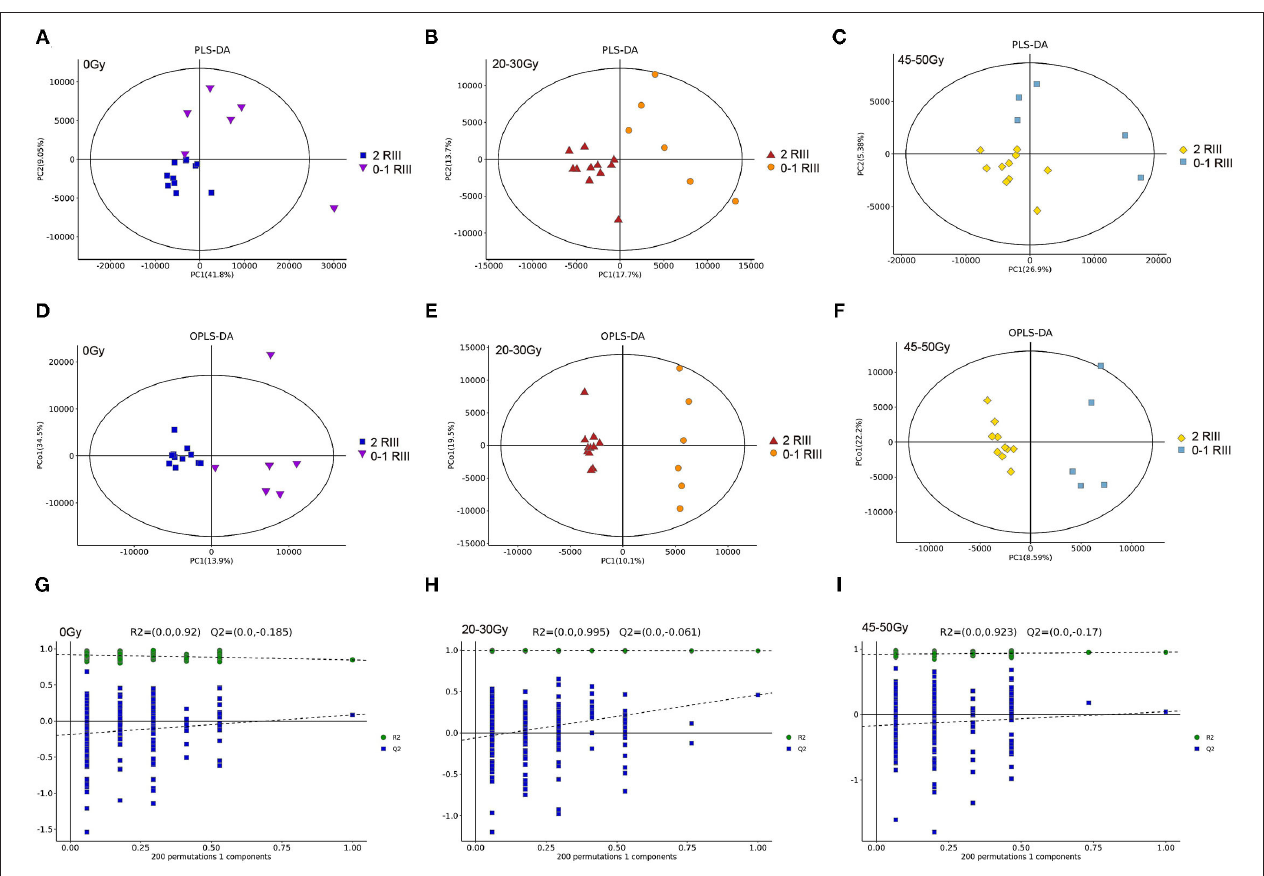
FIGURE 2 | Alterations of gut metabolites between grade 2 and grade 0 or 1 RIII patients at all the three timepoints. (A–F) PLS-DA and OPLS-DA score plots. (G–I) OPLS-DA score